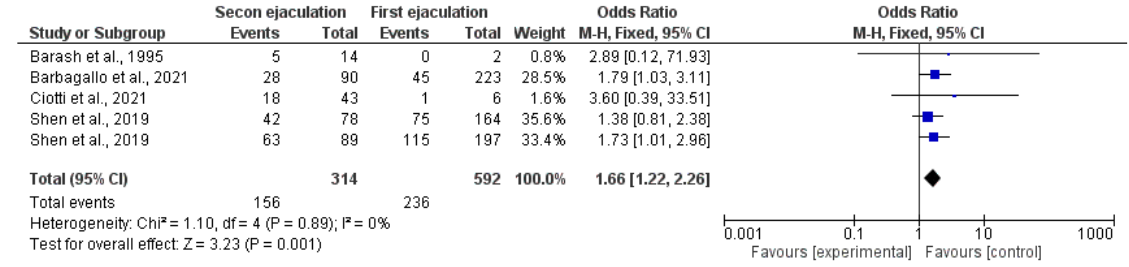
Figure 3. Forest plot of studies showing the effects of a very short abstinence period on implantation rate.